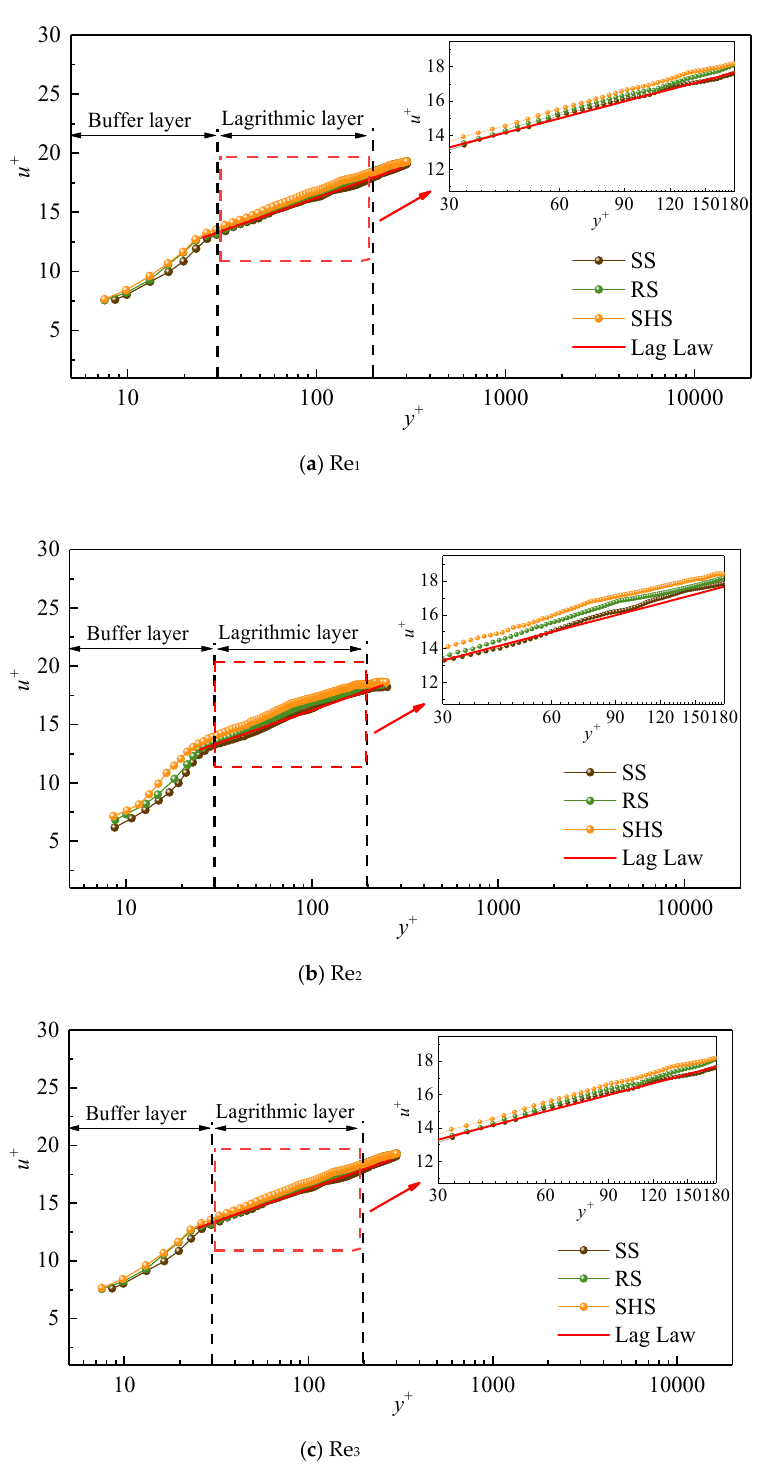
Figure 4. Dimensionless velocity u + of microstructured surfaces along the normal distance y + .